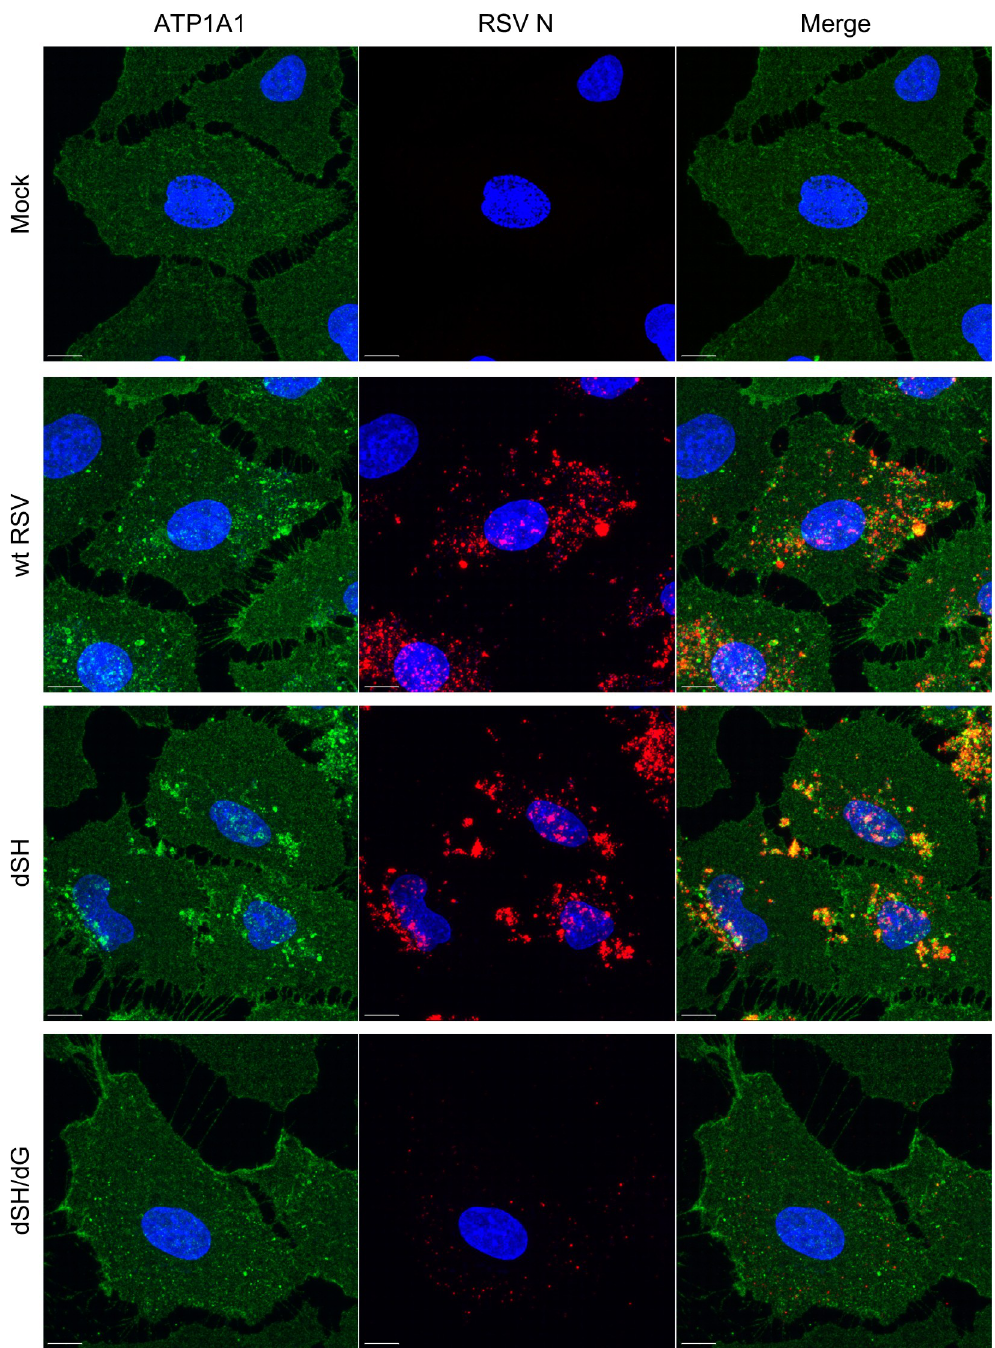
Fig 4. RSV G is required for ATP1A1 clustering. A549 cells were inoculated with wt RSV, rgRSV-dSH or rgRSV-dSH/dG (MOI = 10 PFU/cell) and incubated for 5 h. Cells were fixed with 4% PFA and subjected to immunofluorescence staining, as described for Fig 3. ATP1A1 (green) was detected by an anti-ATP1A1 rabbit MAb (ab76020) and AF568-conjugated donkey anti-rabbit secondary antibody. RSV N (red) was detected by an anti-RSV N mouse MAb (ab94806) and an AF647-conjugated donkey anti-mouse secondary antibody. The cell nuclei were stained with DAPI (blue). Images (z-stacks) were acquired on a Leica SP8 confocal microscope, with a 63x objective (NA 1.4) and a zoom of 3.0. Scale bar 10 μ m.